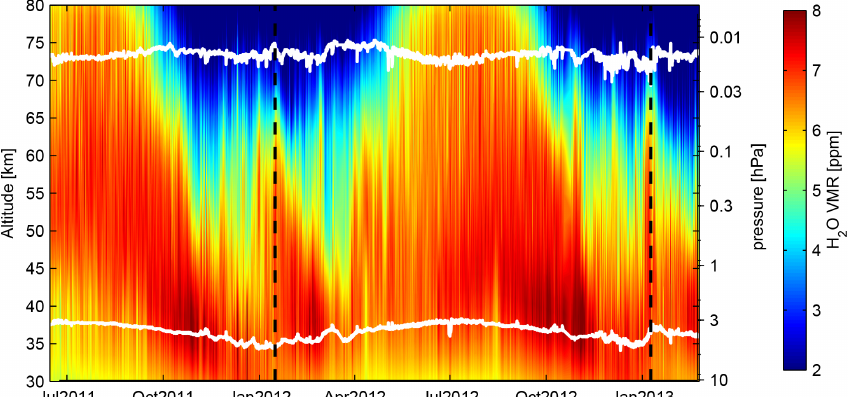
Figure 1. Overview of the water vapour time series measured by MIAWARA-C. The two black dashed lines mark the central dates of the two SSWs. The reliable altitude range is indicated by white lines